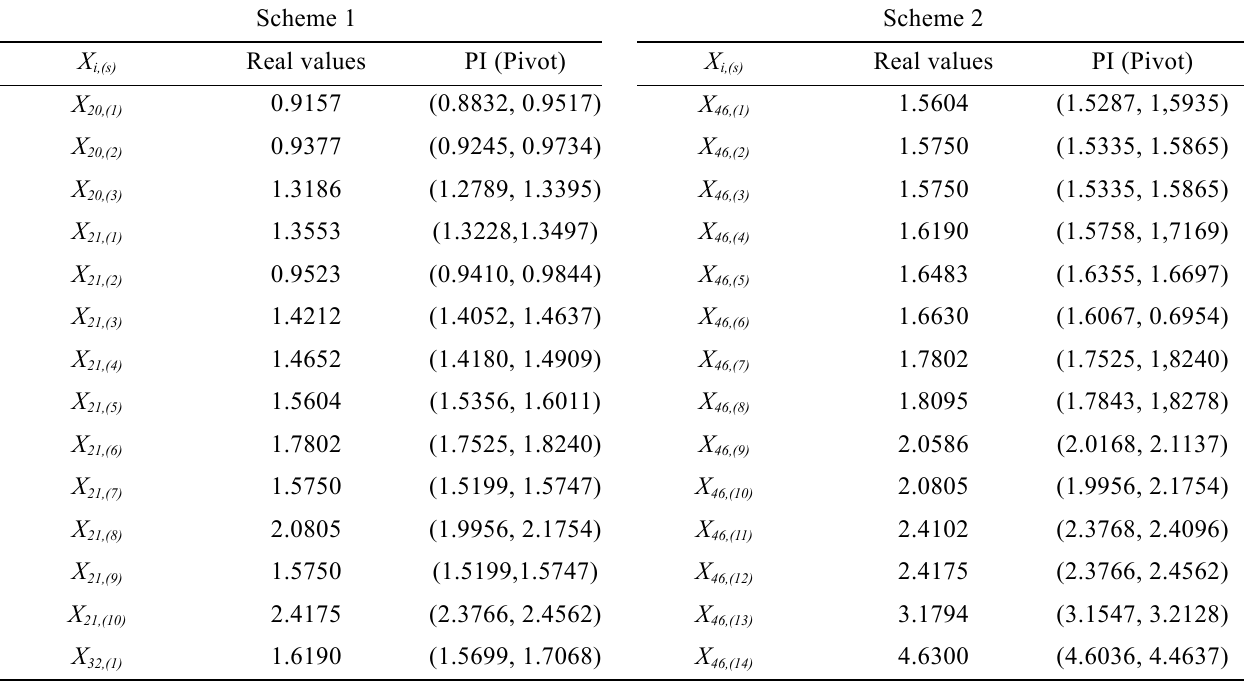
Table 2. Values of interval prediction method for X i,(s) ; s=1, …, r i , (for scheme 1, i=20, 21, 32 and for scheme 2, i=46 ) and their real values.